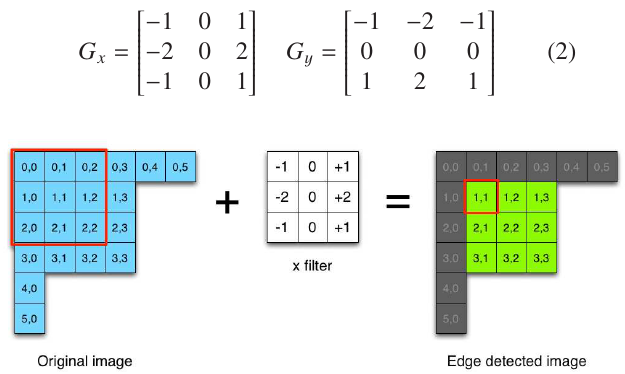
Figure 1. Sobel operator [29]